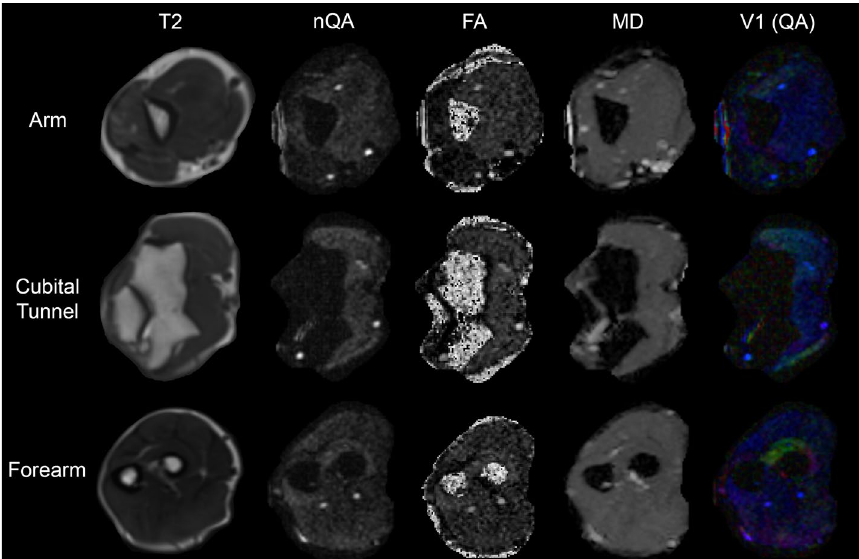
Figure 1. Data derived from a healthy control. The rows show data from the arm, cubital tunnel and forearm. The columns contain T2-weighted scans, and corresponding maps of normalised quantitative anisotropy (nQA), fractional anisotropy (FA), mean diffusivity (MD) and the principal eigenvector (v1) with the colours red, green and blue representing diffusion in x, y and z directions, and the intensity scaled by quantitative anisotropy